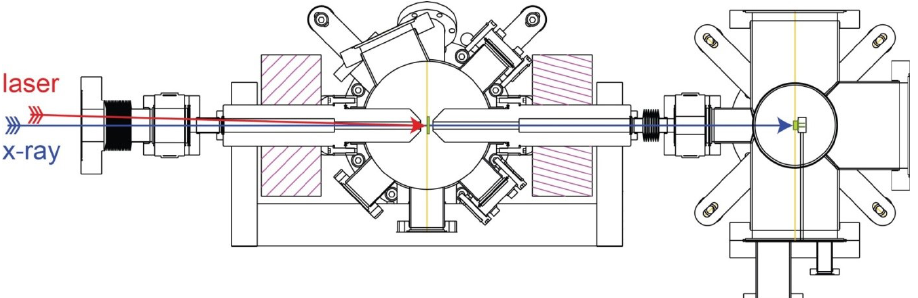
Figure 3: Layout of the fs XMCD/XAS chamber (FemtoSpeX Magnetism).